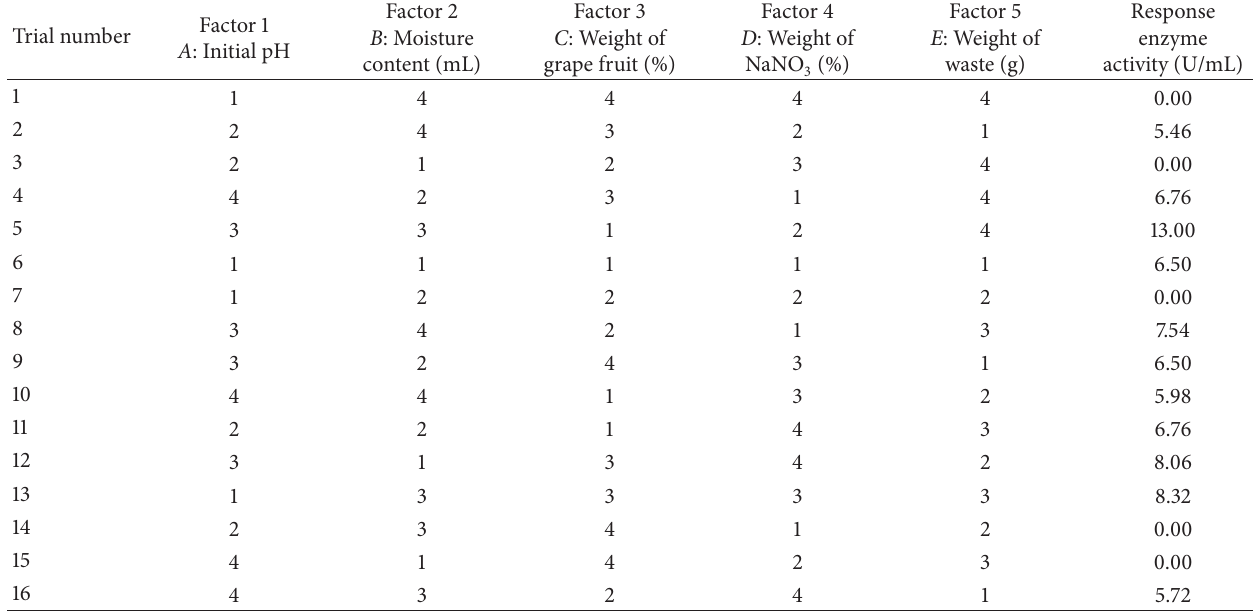
Table 4: Levels of five different factors, applied in each of 16 trials, and the obtained results.